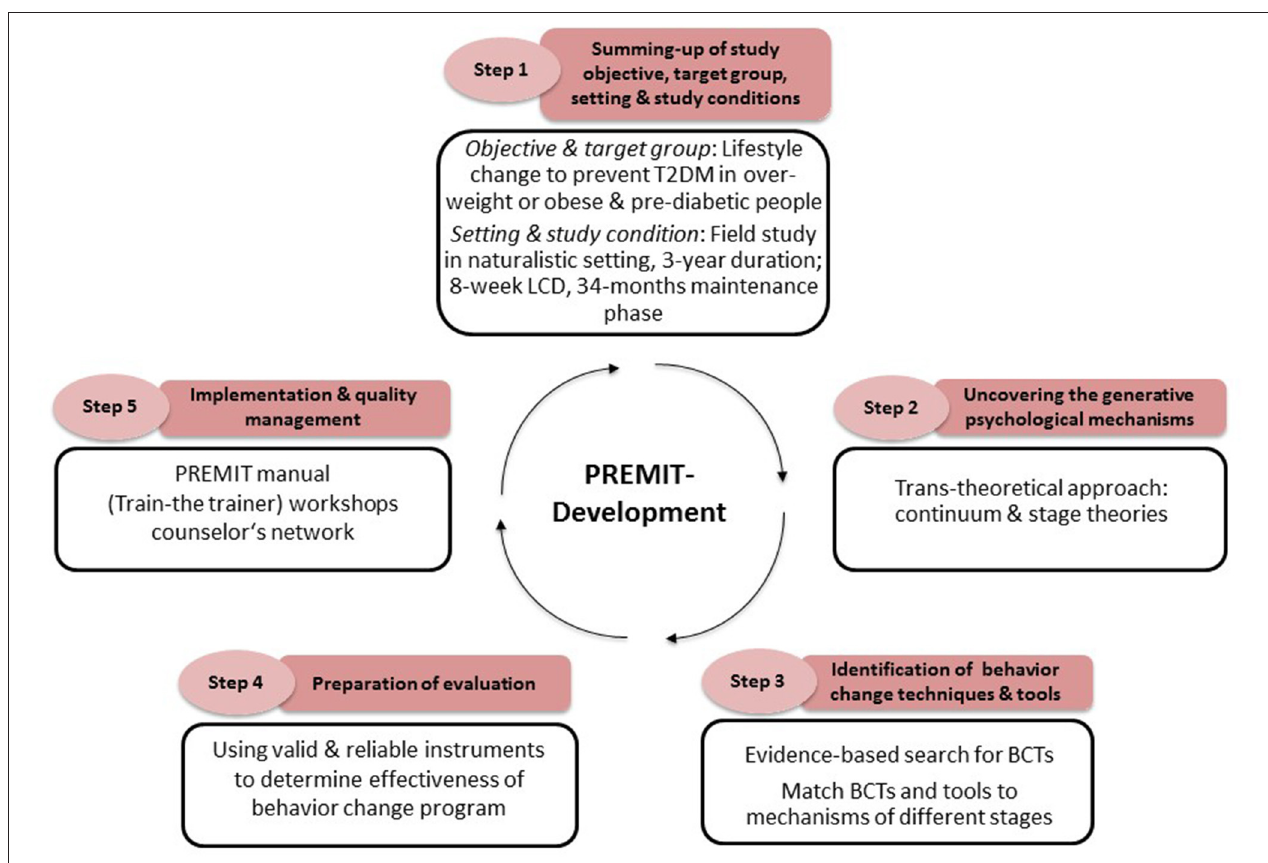
FIGURE 1 | Stepwise and systematic approach for conducting the PREMIT